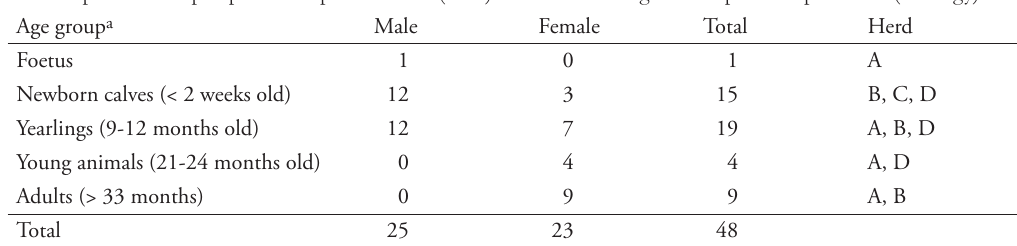
Table 1. Age and sex distribution of 48 reindeer carcasses found on winter pastures and calving grounds in western (herds A and B) and eastern Finnmark (herds C and D). The animals were autopsied and investigated for the presence of parapoxvirus-specific DNA (PCR) and antibodies against herpes- and pestivirus (serology).